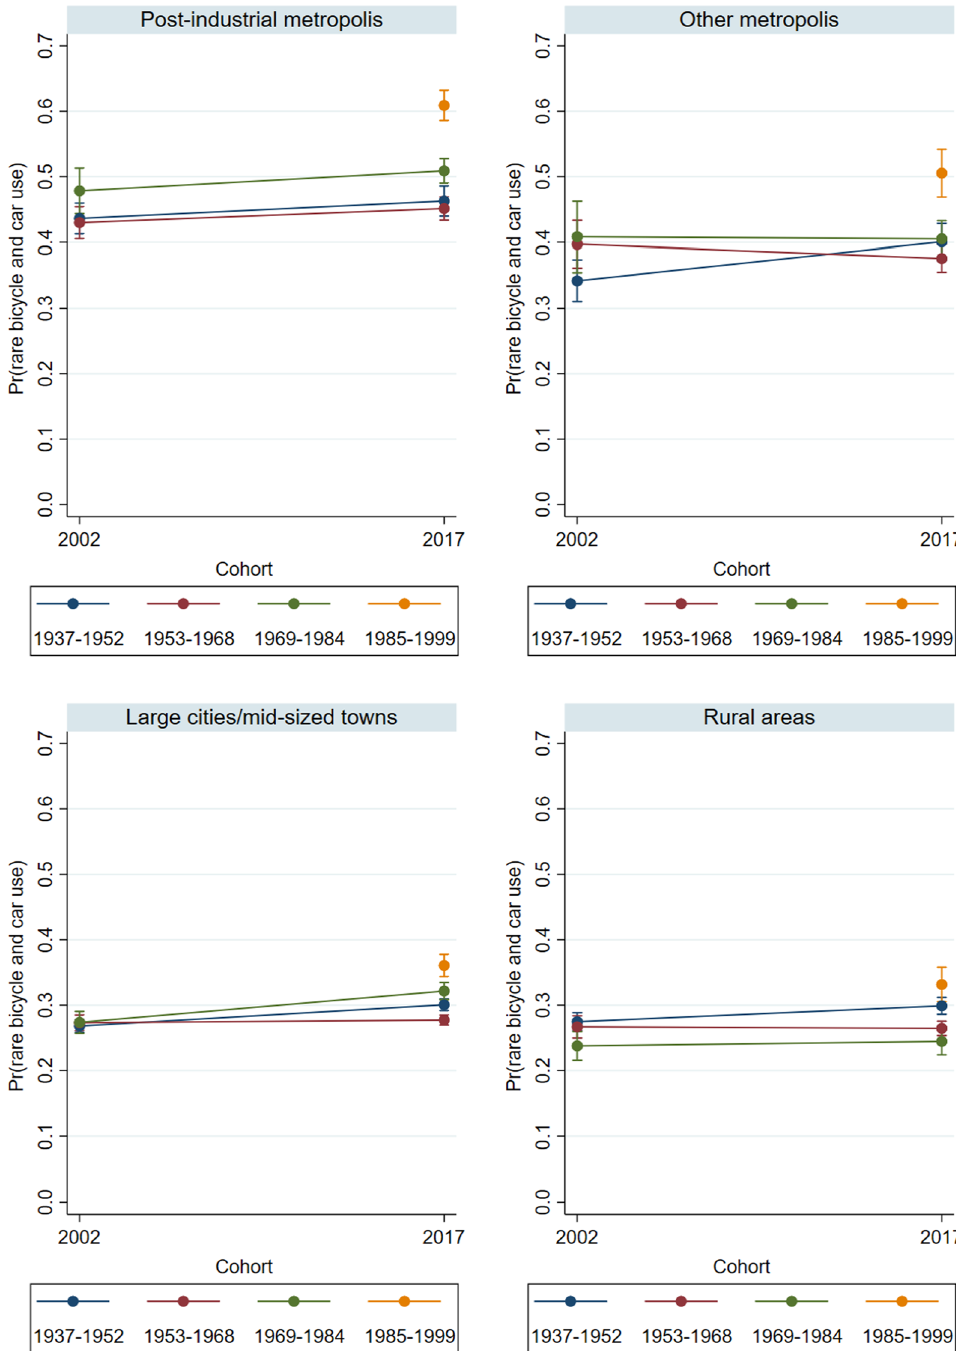
Fig. 7 Predicted probabilities of rare bicycle and car use in 2002 and 2017 – by settlement type (Model 2). Source: Mobility in Germany: MiD person-time-series dataset (own calculations). Note: Rare bicycle and car use is defined as bicycle use of at most 1 to 3 times per week and car use of at most 1 to 3 times per week. Survey weights are applied. See also Table 6 for main effects and standard